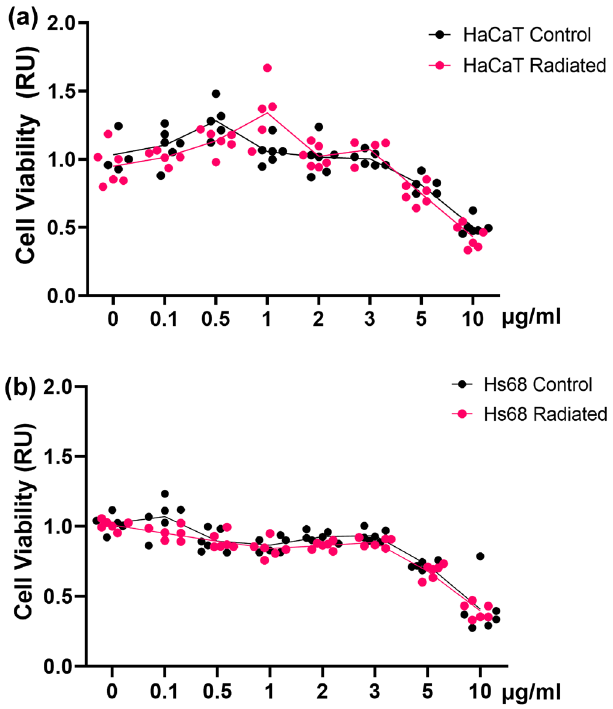
Figure 1. A mixture of plant extracts from agrimonia, houttuynia, licorice, peony, and phellodendron (hereafter AHLPP) induced subtle cell death in human epidermal keratinocyte and dermal fibroblasts. ( a ) HaCaT cells and ( b ) Hs68 cells were treated with the AHLPP extract for 48 h. Cell viability was assessed based on the activity of cytoplasmic